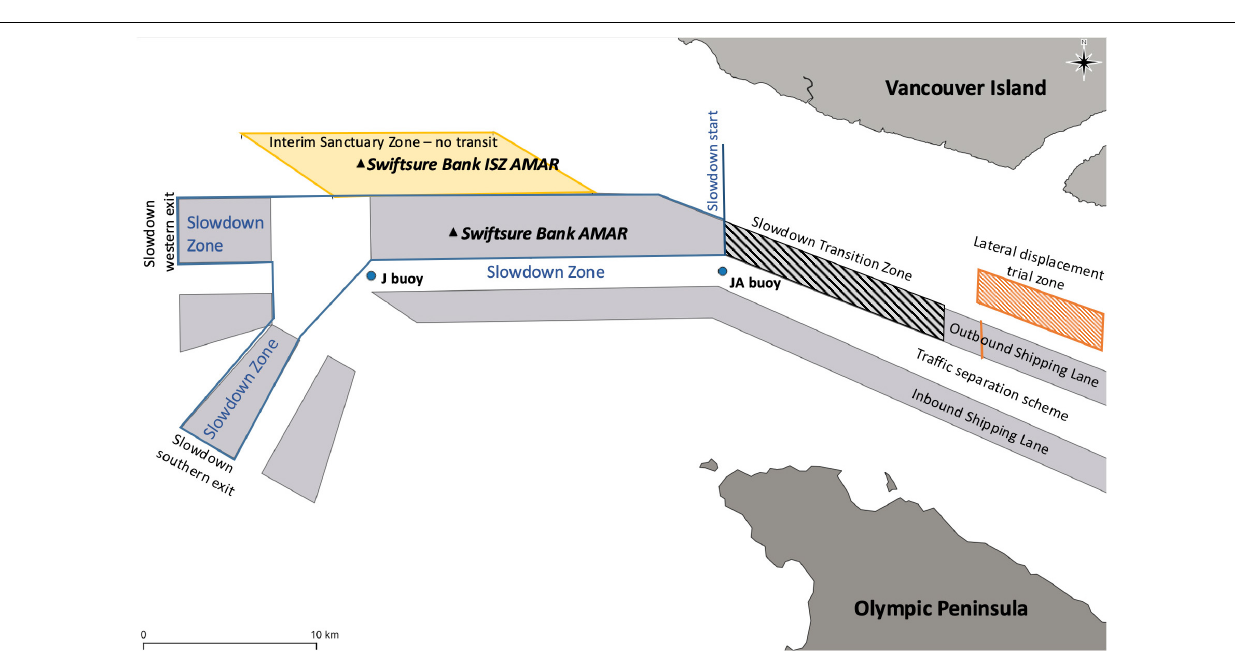
FIGURE 3 | The voluntary slowdown area and transition zones on Swiftsure Bank, with slowdown requested west of the JA buoy. The mooring locations used to assess the slowdown are shown with black triangles and labeled as AMAR. The Interim Sanctuary Zone (ISZ) is indicated in yellow, and the start of the lateral displacement trial zone in Juan de Fuca in